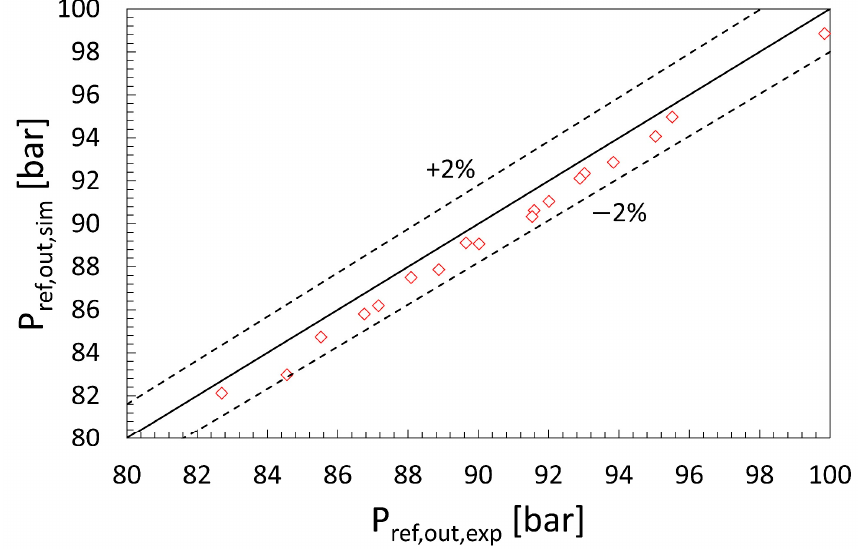
Figure 12. Comparison between the simulated refrigerant outlet pressures obtained by the numerical model and the corresponding experimental data for different working conditions of the gas cooler. The experimental distribution of the airflow was considered for the simulations.